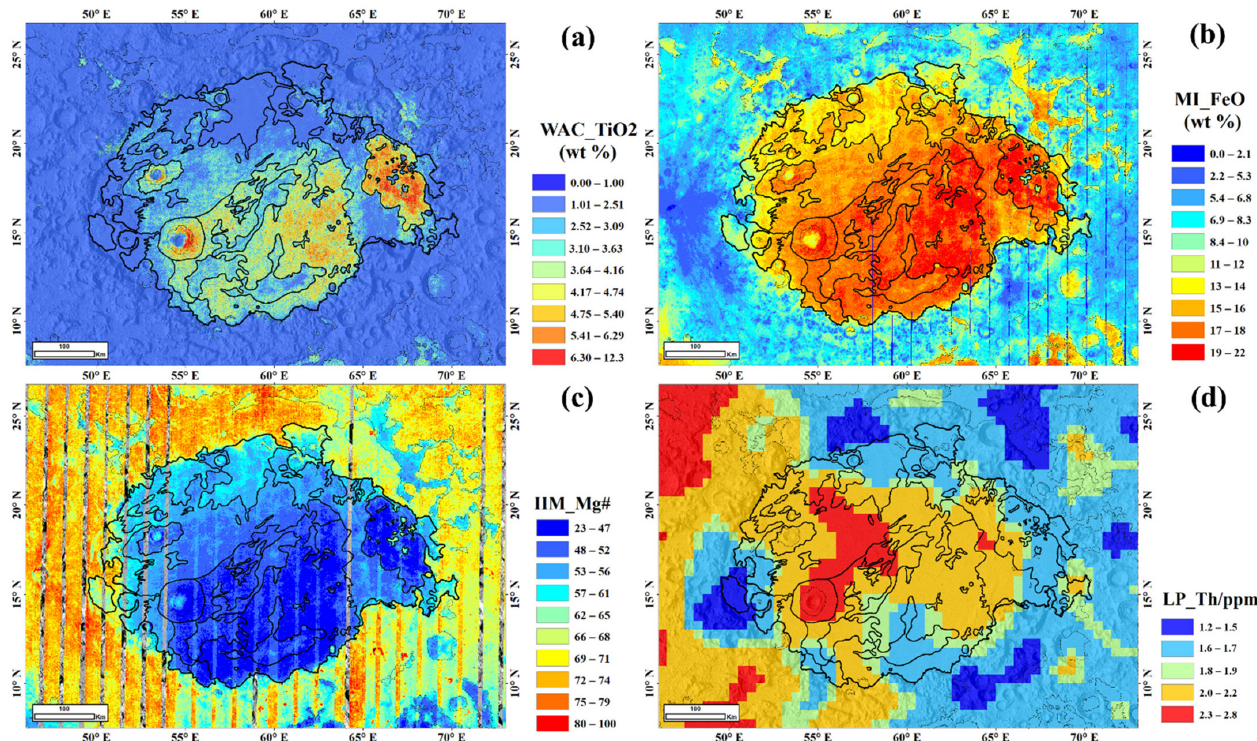
Figure 8. Maps of the ( a ) TiO 2 abundance, ( b ) FeO abundance, ( c ) Mg#, and ( d ) Th content around the Crisium basin. The base map is a LOLA DEM. The black lines represent the boundaries of mare and